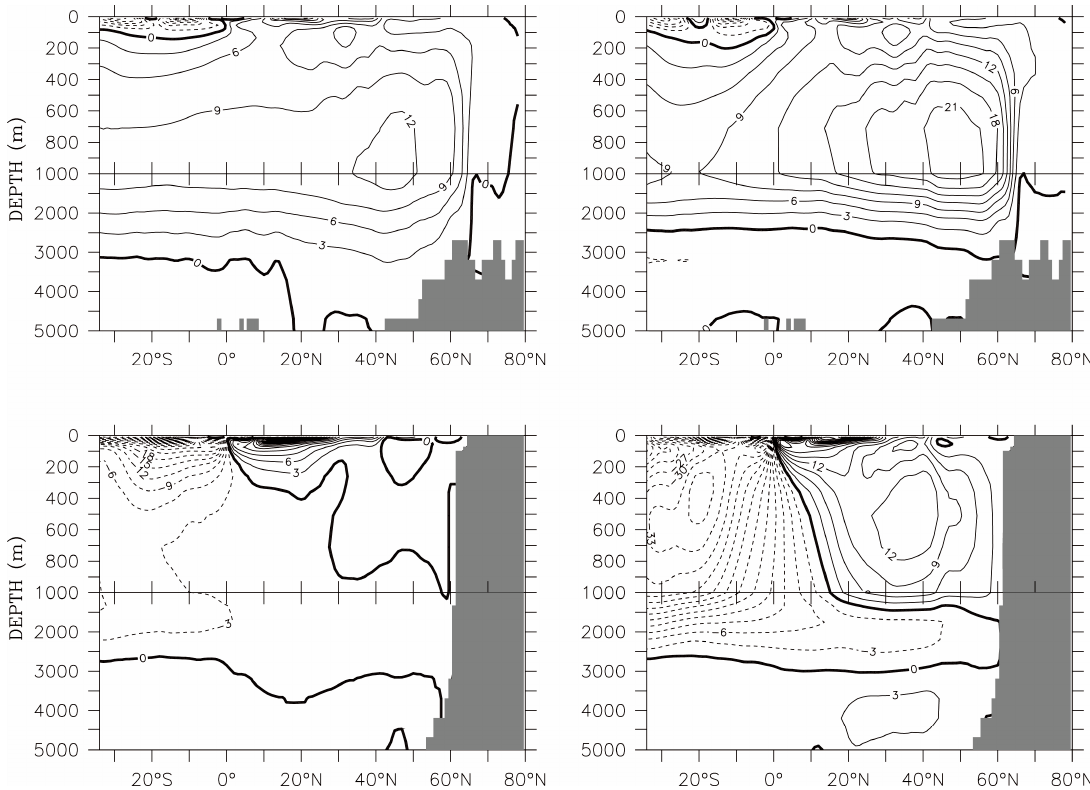
Figure 8. Average streamfunctions (Sv) from Equation (10) in the Atlantic ( upper ) and the Indo-Pacific ( lower ) with OTEC ( W15 , right ), or without ( CTL , left ).